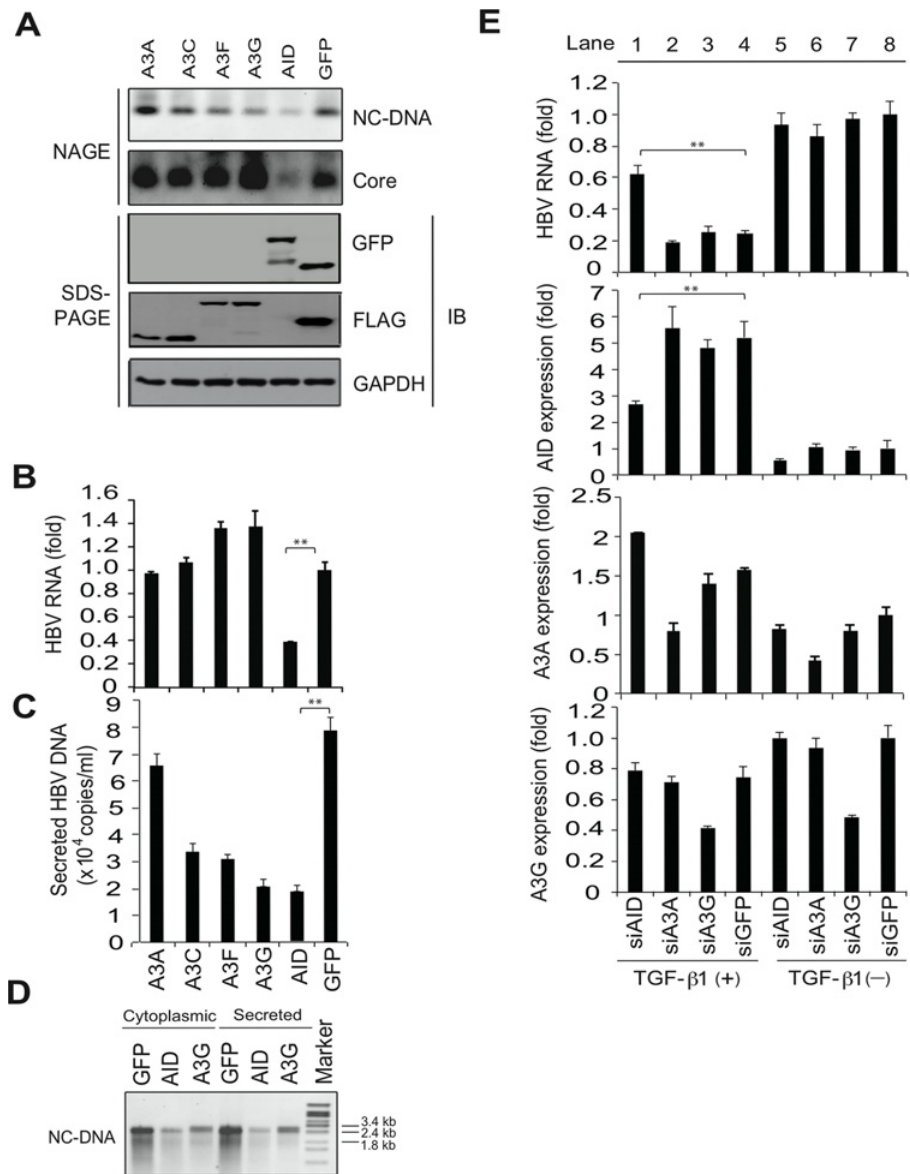
Fig 2. AID is responsible for TGF- β 1-mediated reduction of HBV transcripts. To evaluate antiviral activity of indicated APOBEC proteins, Huh7 cells were co-transfected with FLAG-tagged A3A, A3C, A3F, A3G, GFP or GFP-tagged AID expression vectors and pPB. Cells were cultured for 3 days, and then HBV replication was estimated using NAGE assays (A). Protein expression is shown (A, bottom). qRT-PCR analyses of HBV transcripts (B), and qPCR analyses of NC-DNA in secreted virions (C). (D), Secreted virions in the culture medium and cytoplasmic extracts were treated with proteinase K and SDS to digest nucleocapsids, and levels of HBV DNA were determined using Southern blotting. (E), To evaluate contribution of indicated APOBEC proteins, Huh7 cells were co-transfected with pPB and the indicated siRNAs. Six hours later, cells were incubated in the presence or absence of 10 ng/mL TGF- β 1. Three days later, total RNA was extracted, and qRT-PCR performed to determine expression levels of HBV transcripts, AID, A3A, and A3G. Although siAID significantly reduced AID expression and prevented the downregulation of HBV transcripts in TGF- β 1-stimulated Huh7 cells (lane 1), siA3A and siA3G had no effects against the downregulation of HBV transcripts (lanes 2 – 4). siGFP was used as a control. Expression levels in lane 8 are defined as one fold induction. ** P < 0.01 ( t -test); Data are representative of two to three independent experiments and error bars represent standard errors of the